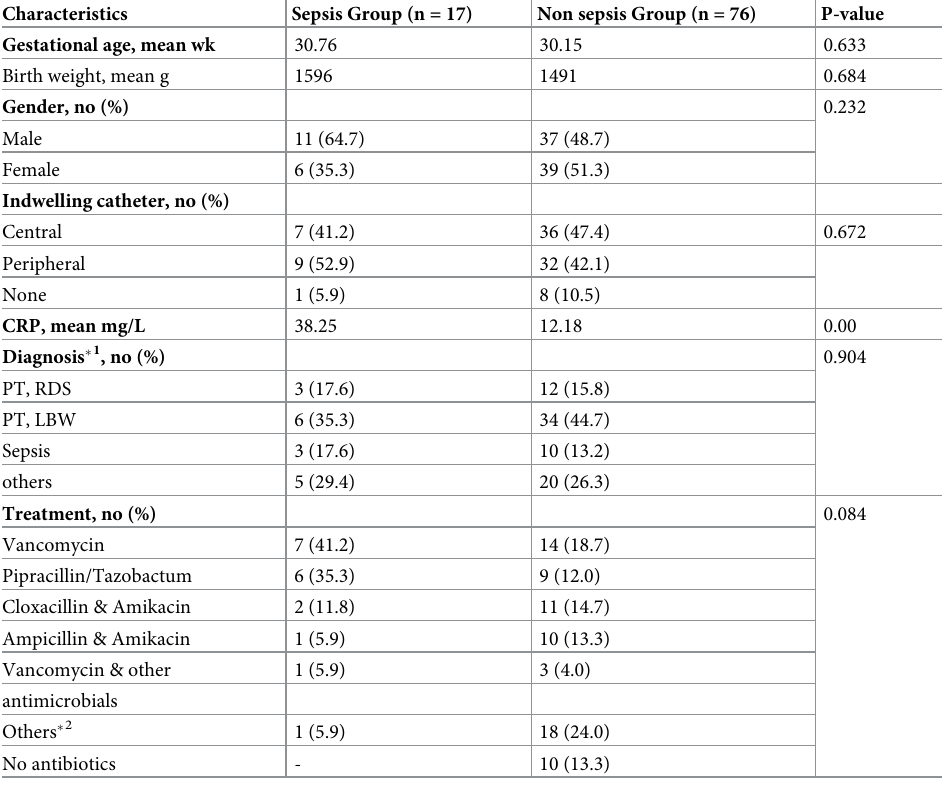
Table 2. Characteristic of neonates with coagulase-negative staphylococcal sepsis and non-sepsis blood cultures (n = 93). Characteristics